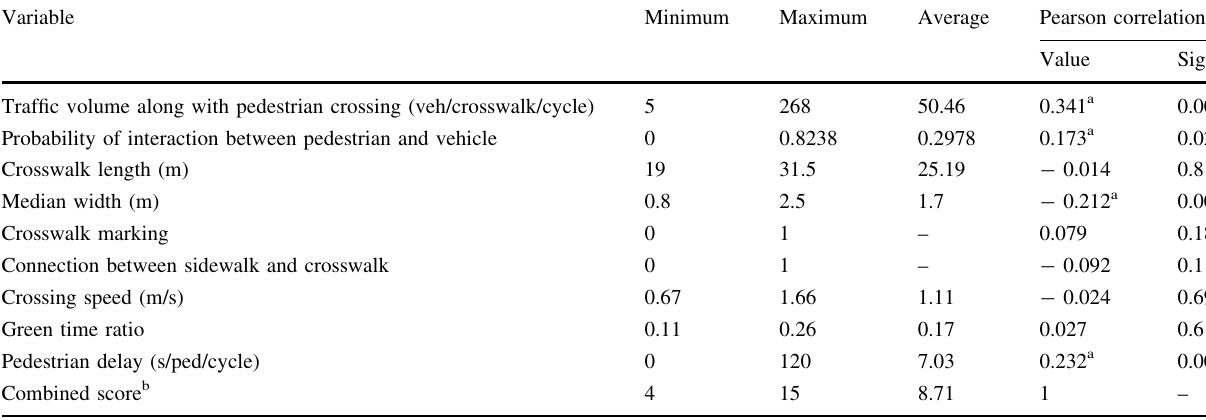
Table 3 Statistics of selected variables and Pearson correlation results Variable